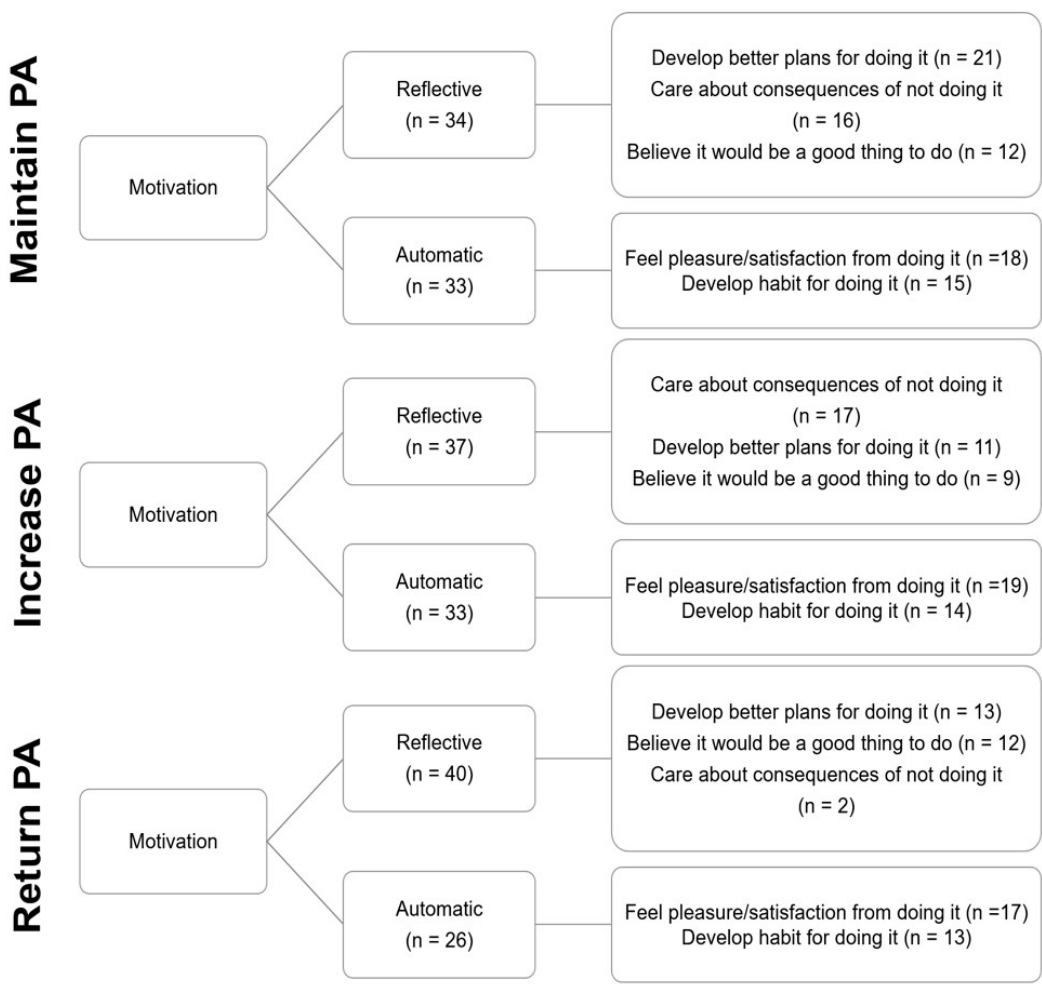
Figure 6. Perceived motivation barriers grouped by intended PA target behaviour.